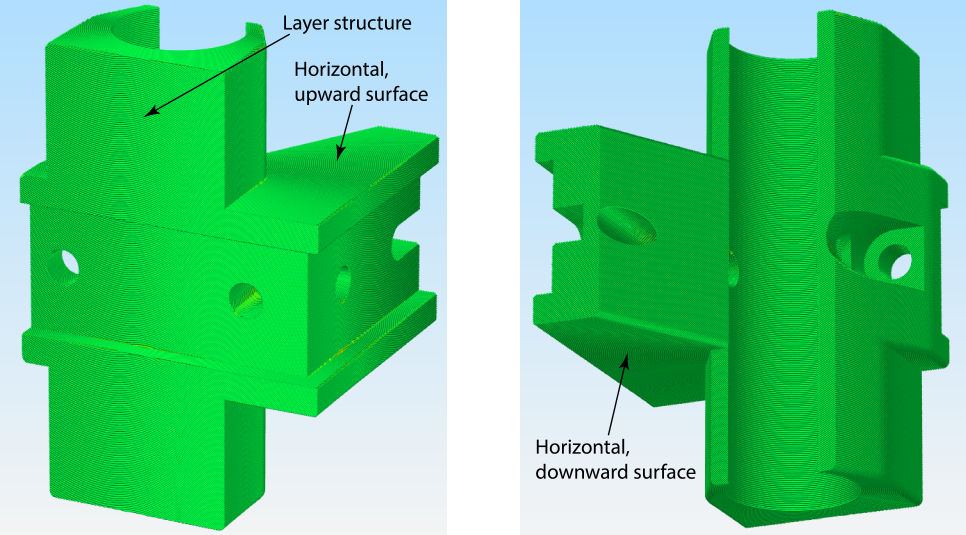
Figure 15. Conical sliced reference part in Simplify3D preview with the areas investigated